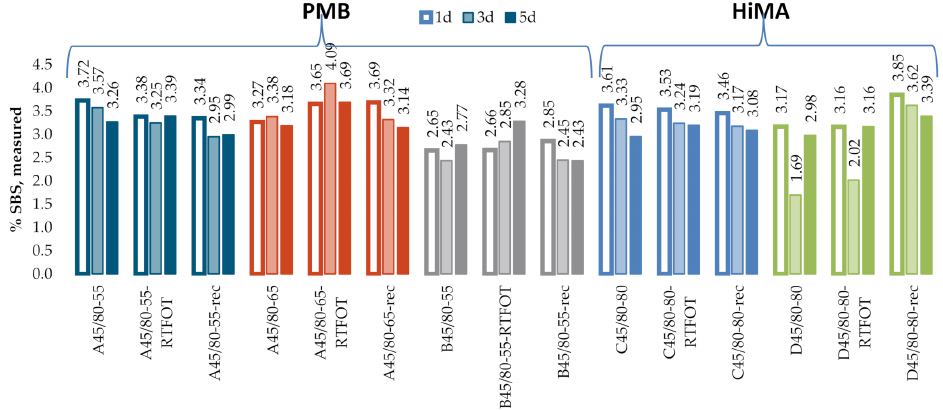
Figure 8. SBS contents in industrial samples, transmission